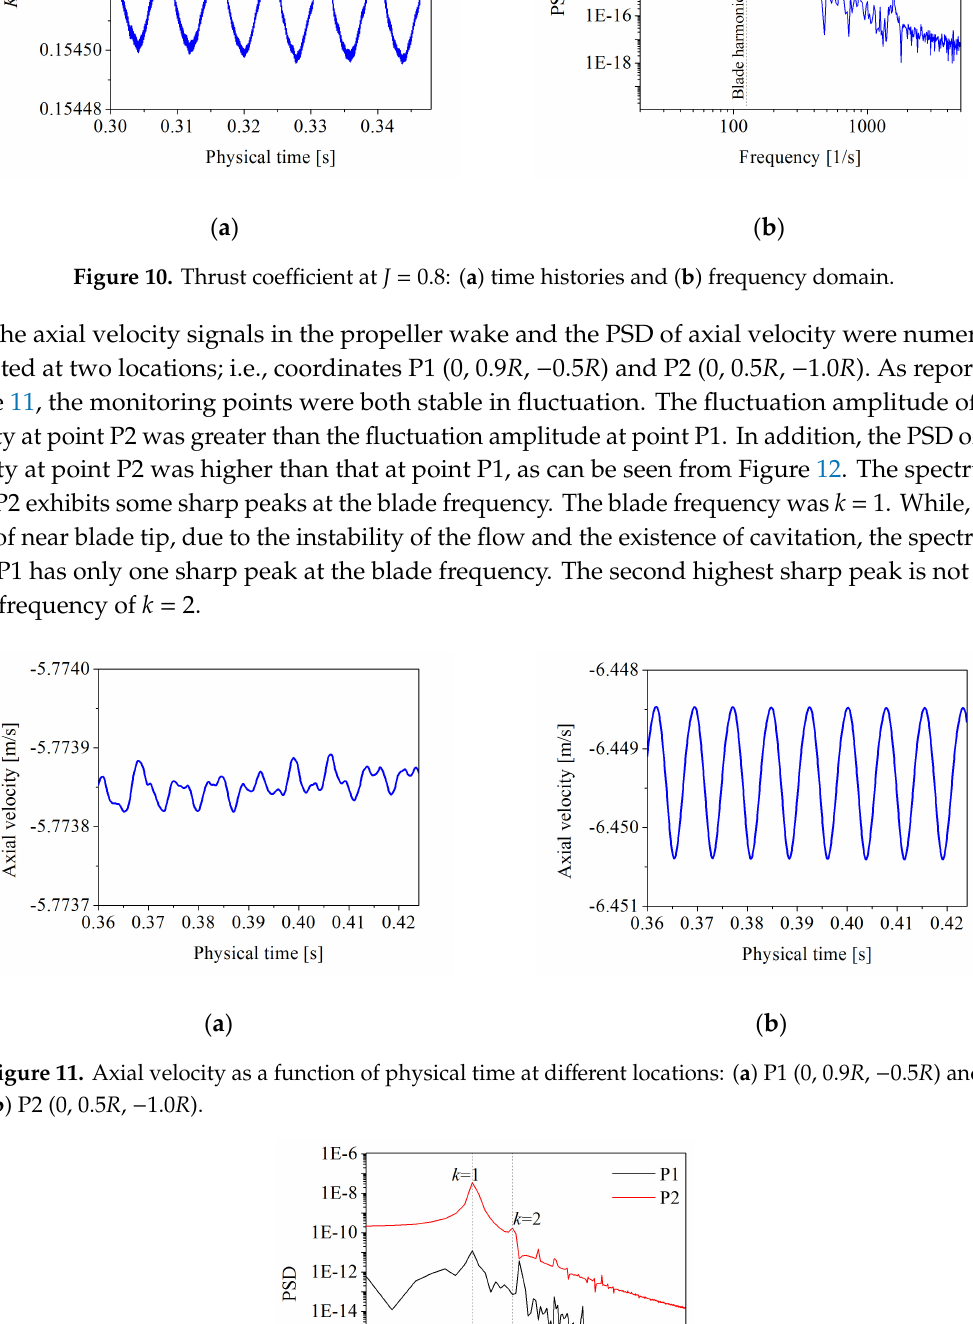
Figure 12. Power spectral density (PSD) of axial velocity at different locations.